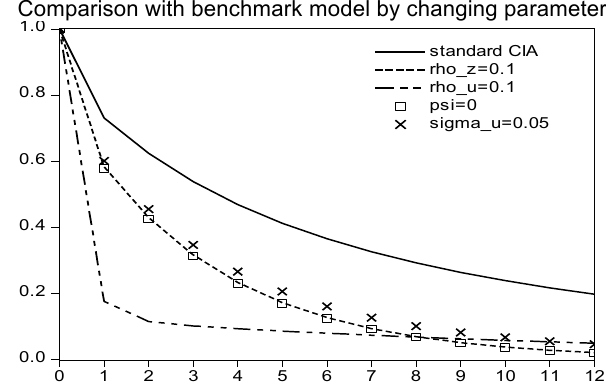
Comparison with benchmark model by changing